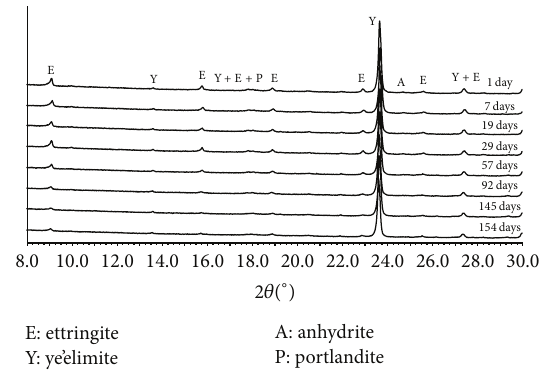
Figure 2: XRD patterns of hydrated ye’elimite clinker exposed to laboratory settings, age 1–159 days of